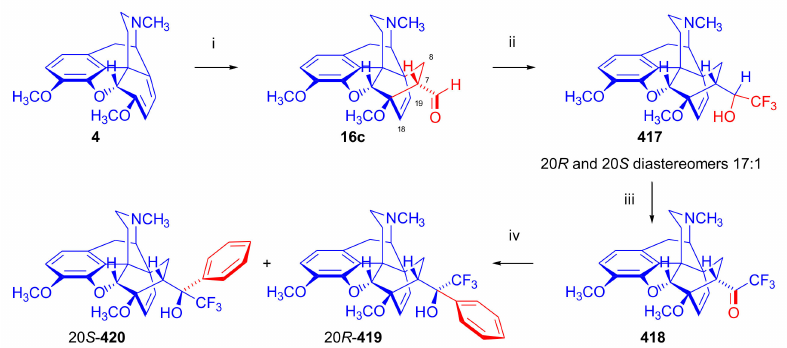
Figure 105. Synthesis of fluorinated 20 R - and 20 S -phenylthevinols. Reagents and conditions : (i): acroleine, benzene, reflux; (ii): (1) Me 3 SiCF 3 , TBAF, THF, (2) HCl/H 2 O; (iii): DMSO, oxalyl chloride, CH 2 Cl 2 , (1) -70 ◦ C, 1.5 h, (2) Et 3 N, 20 ◦ C, 10 min; and (iv): phenylmagnesium bromide, THF, 20 ◦ C, 24